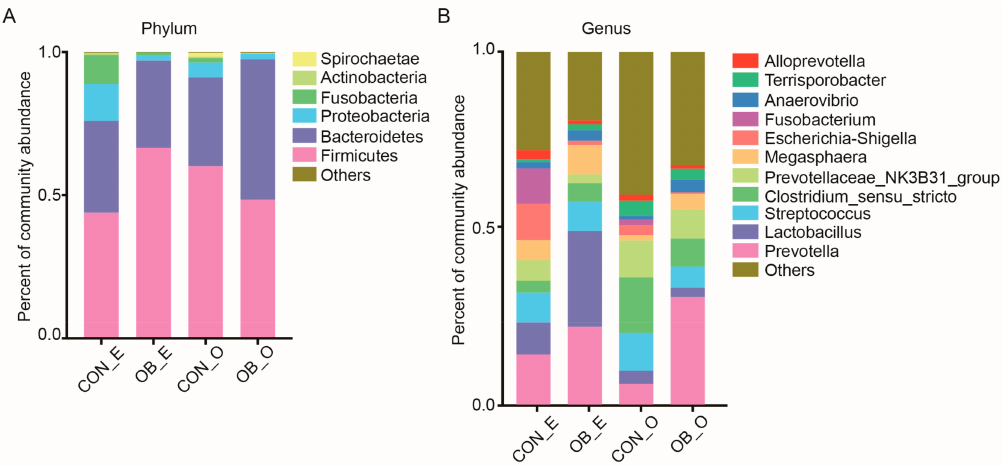
Figure 2. Microbiota composition in the caecal (E) and colonic (O) digesta from growing pigs fed either control (CON) or oat bran diet (OB). ( A ) Microbiota composition in the caecal and colonic digesta at the phylum level; ( B ) microbiota composition in the caecal and colonic digesta at the genus level. The results were presented as mean percentage of different bacteria, n = 4.